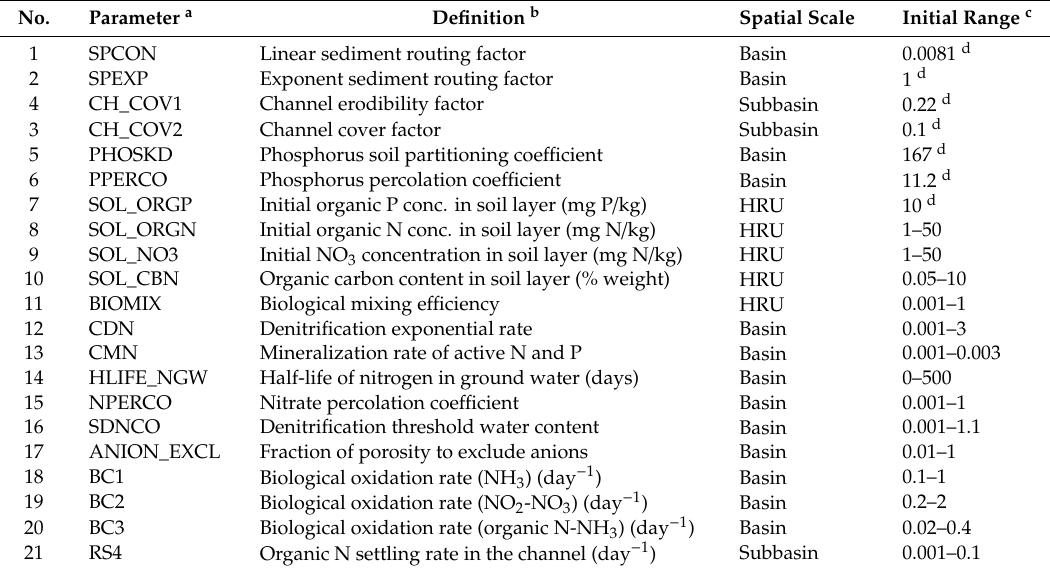
Table A2. Parameters included in the nitrate calibration of the Cedar River Watershed model. See supplementary information for the most optimal parameter values a